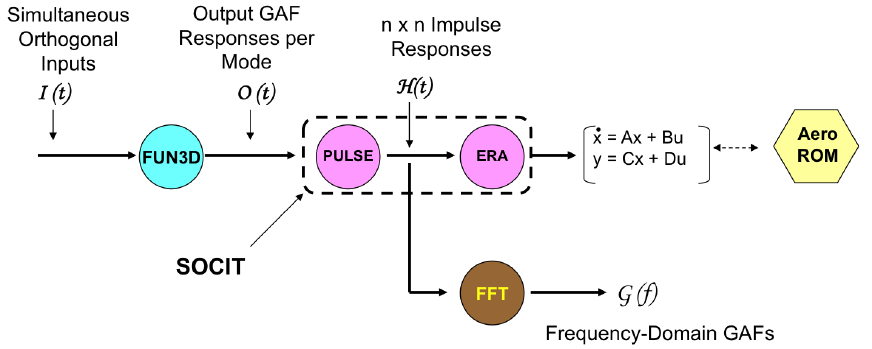
Figure 2. Improved process for generation of an unsteady aerodynamic reduced-order modeling (ROM) (Steps 1–4).